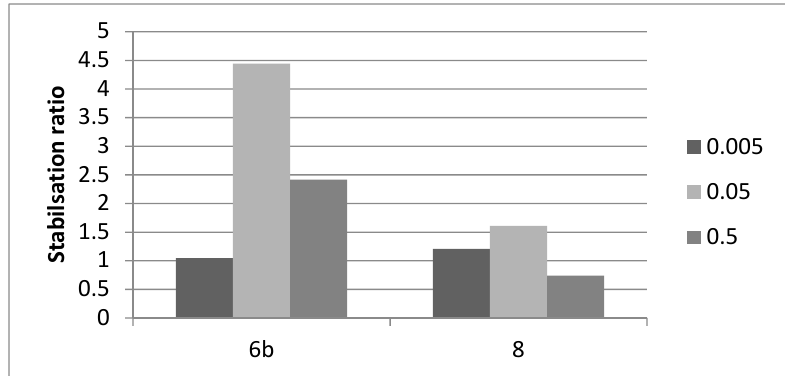
Figure 5. Ability of compounds 6b and 8 to stabilize GBA. Enzyme activity was tested in the absence or presence of the inhibitor at 0.5, 0.05 and 0.005 μ M. Data are expressed as the stabilization ratio (the ratio of relative enzymatic activities measured in the presence of inhibitor vs control) of after thermal denaturation (48 °C) for 60 min at the indicated inhibitor concentrations ( μ M).